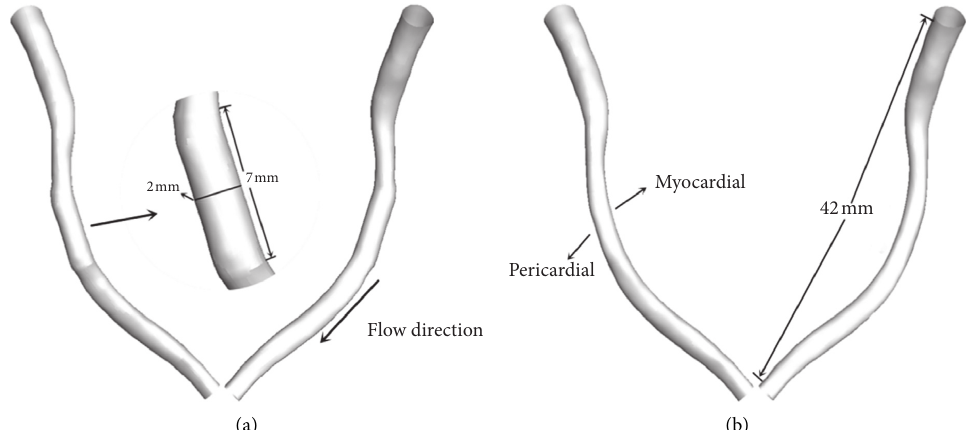
Figure 1: (a) Straightening and (b) normal models. The enlarged image shows the straightening phenomenon caused by stent